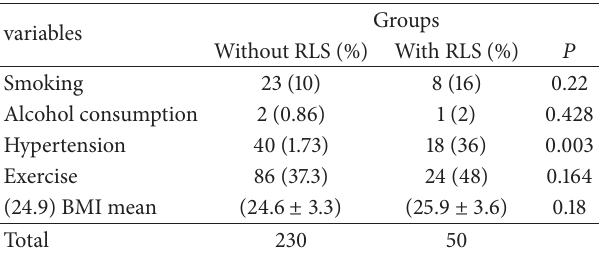
Table 3: Comparison of related variable in groups with and without